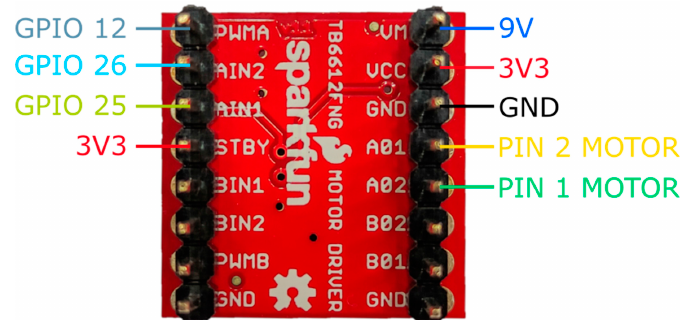
Figure 4. LEGO ® , Motor wiring diagram.